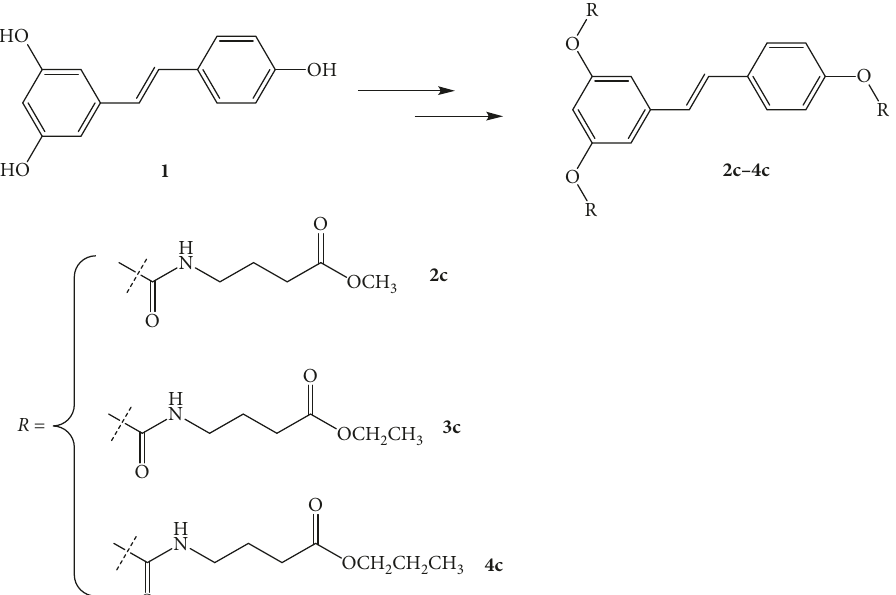
Scheme 1: Molecular structure of resveratrol and its carbonate